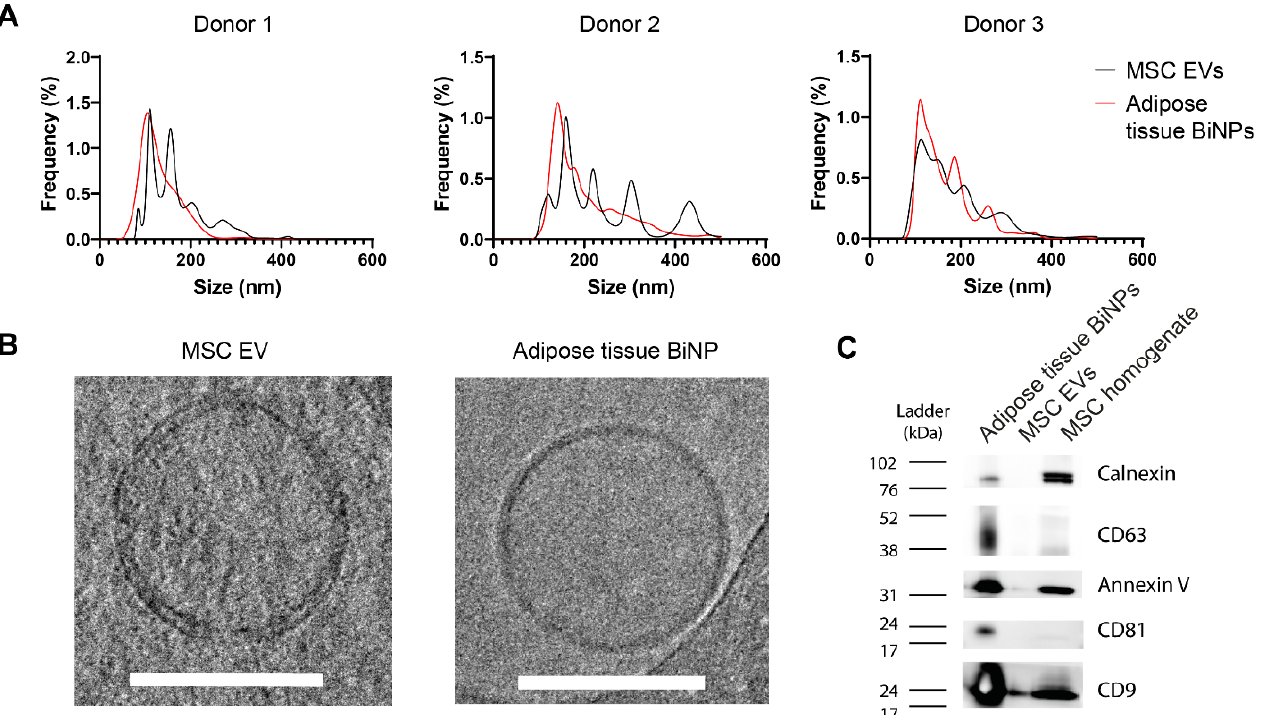
Figure 1. Characterization of donor-matched adipose-derived mesenchymal stromal cell (MSC) extracellular vesicles (EVs) and adipose tissue biogenic nanoparticles (BiNPs). ( A ) Size distribution determined by nanoparticle tracking analysis. ( B ) Morphological evaluation of EVs/BiNPs by cryogenic transmission electron microscopy. Scale bars, 100 nm. ( C ) Protein characterization of EVs/BiNPs by Western blot (samples were normalized to protein concentration). CD, cluster of differentiation.